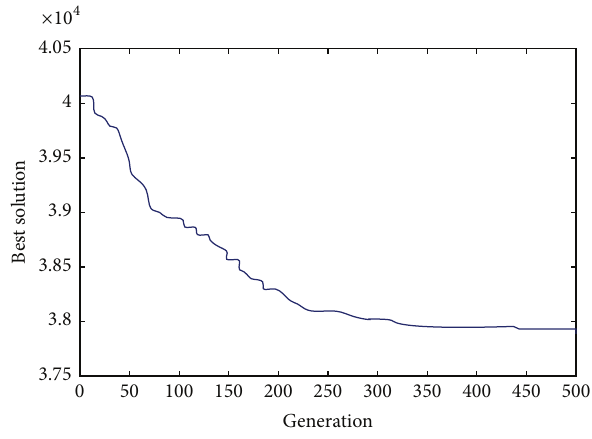
Figure 2: The evolution of best solution when 𝑚 = 9, 𝑛 = 10 .